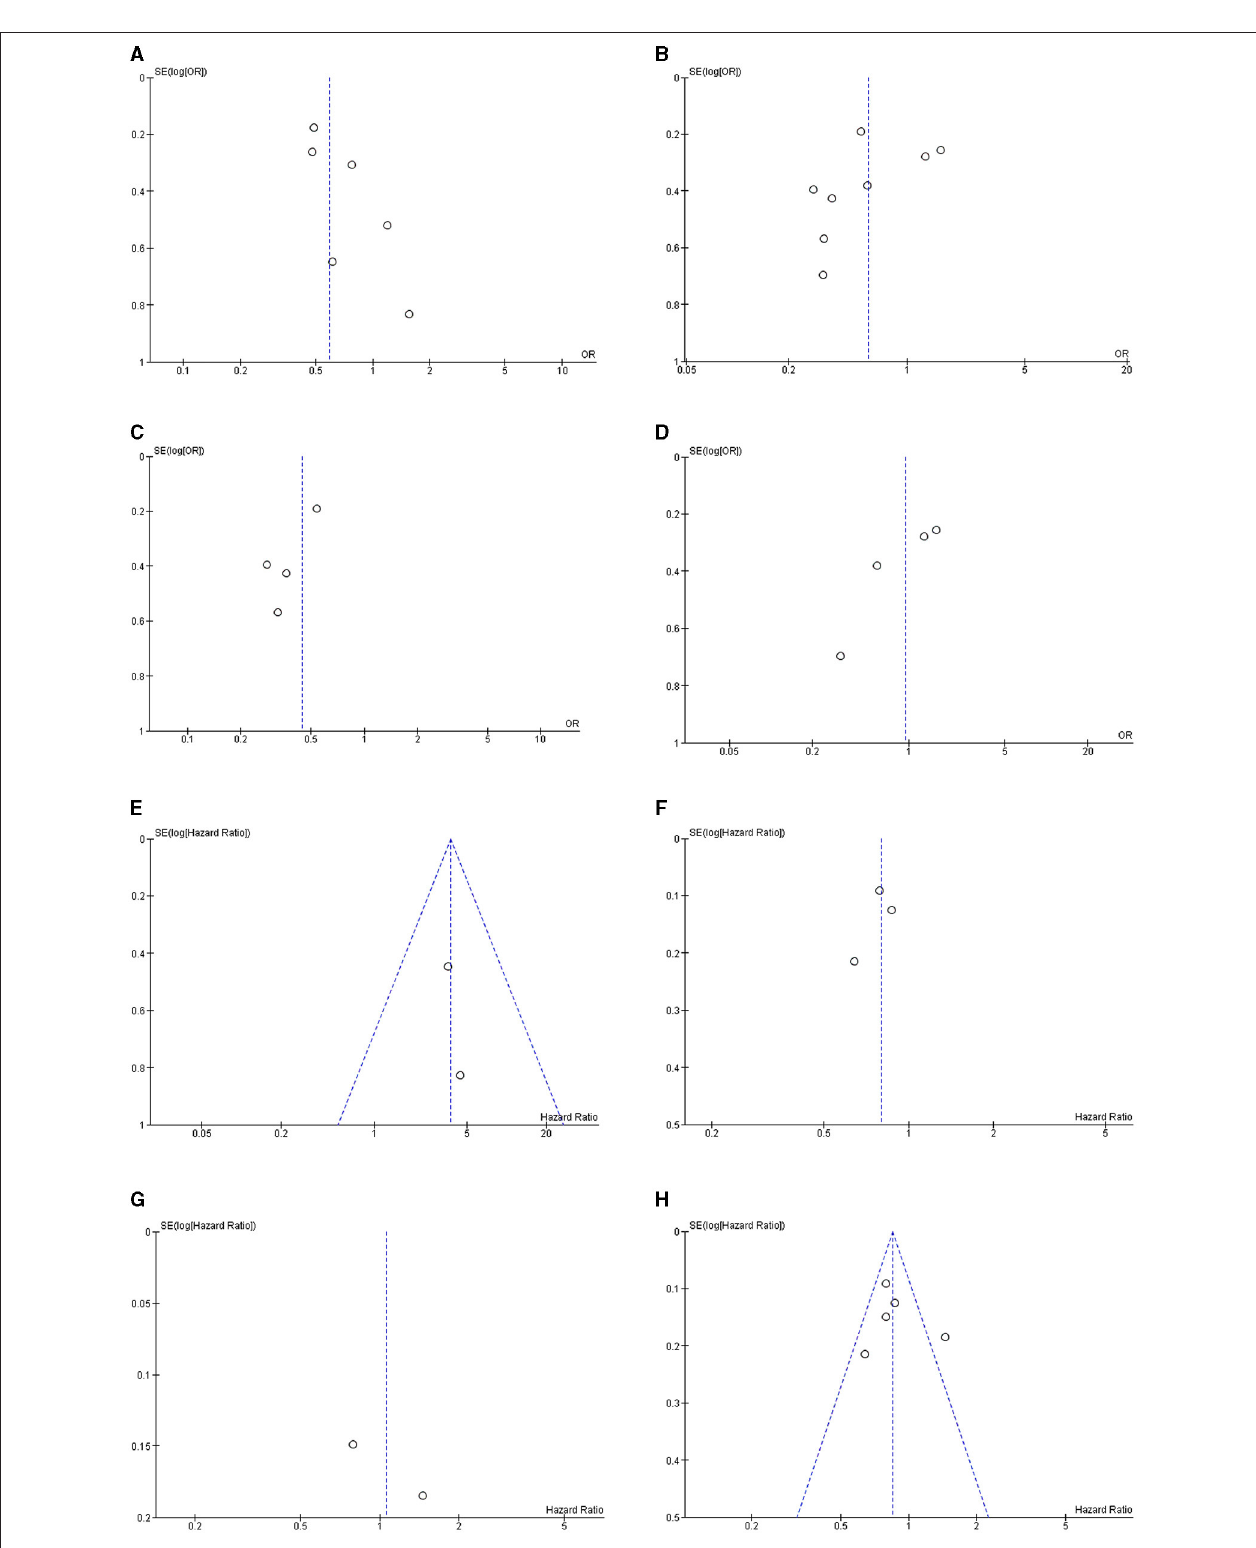
FIGURE 3 | Funnel plot of meta-analyses for the association between modest alcohol consumption in NAFLD patients and (A) steatohepatitis; (B) advanced fibrosis; (C) advanced fibrosis among high-quality studies; (D) advanced fibrosis among low-quality studies; (E) the development of HCC; (F) mortality for light alcohol consumption; (G) mortality for moderate alcohol consumption; and (H) light-to-moderate alcohol consumption.